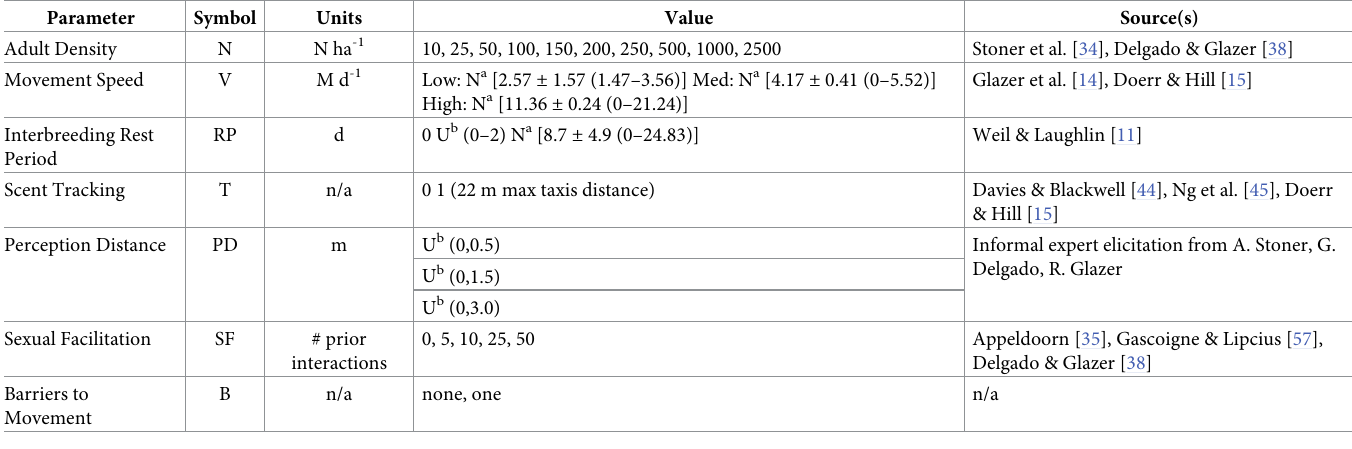
Table showing the parameters evaluated in simulation models. a Truncated normal distribution [Mean ± SD (Min–Max)]